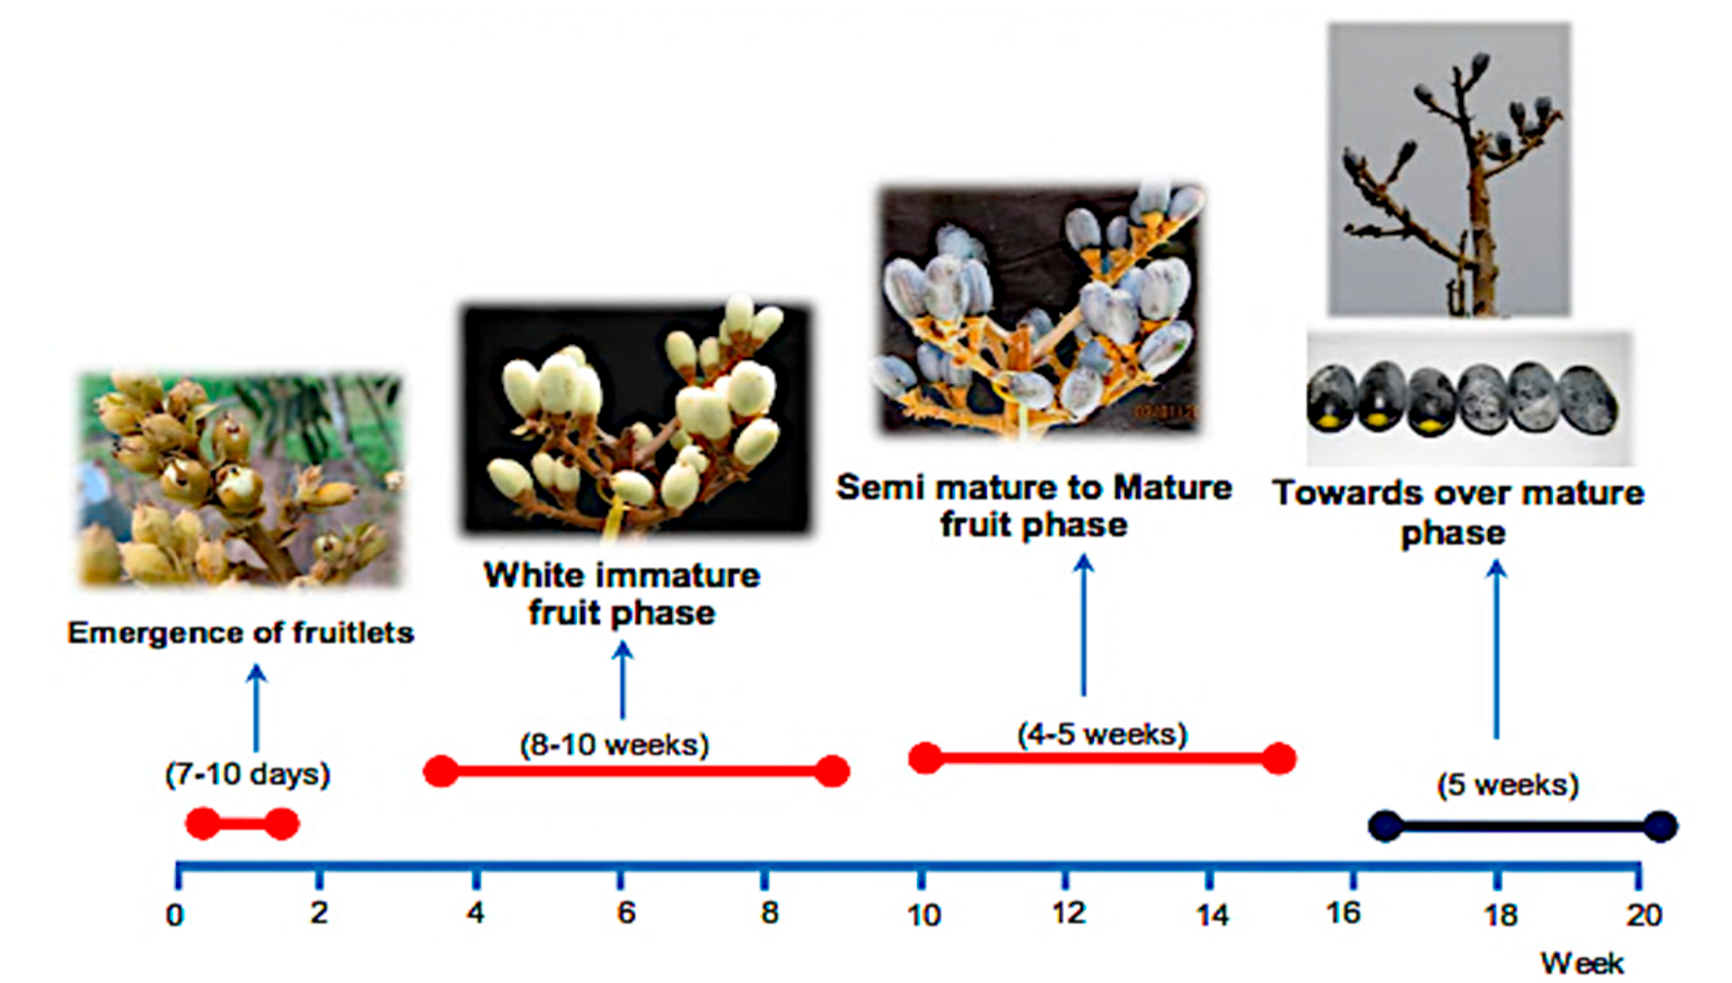
Figure 1. Timeline chart of dabai fruit during the maturation process. Adapted from [29].